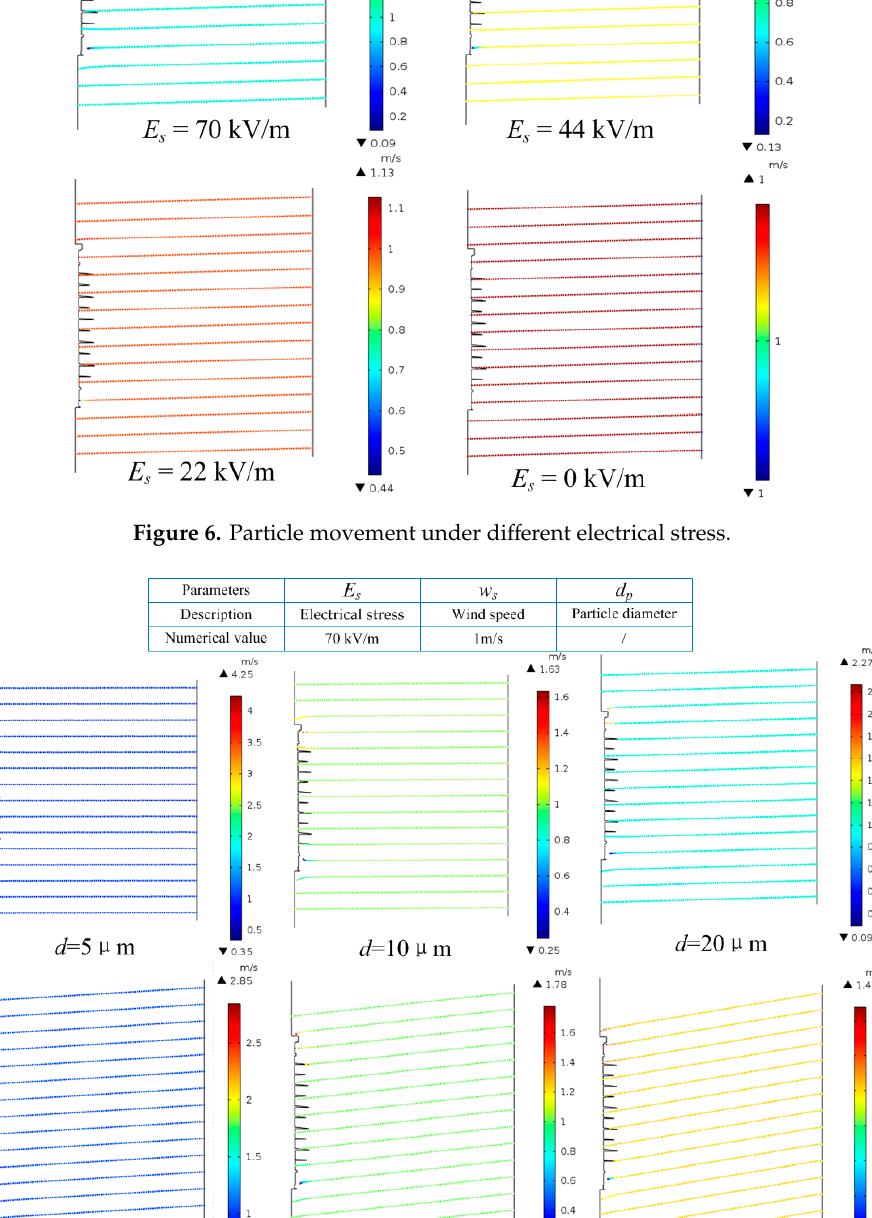
Figure 8. Particle movement with different wind speeds.